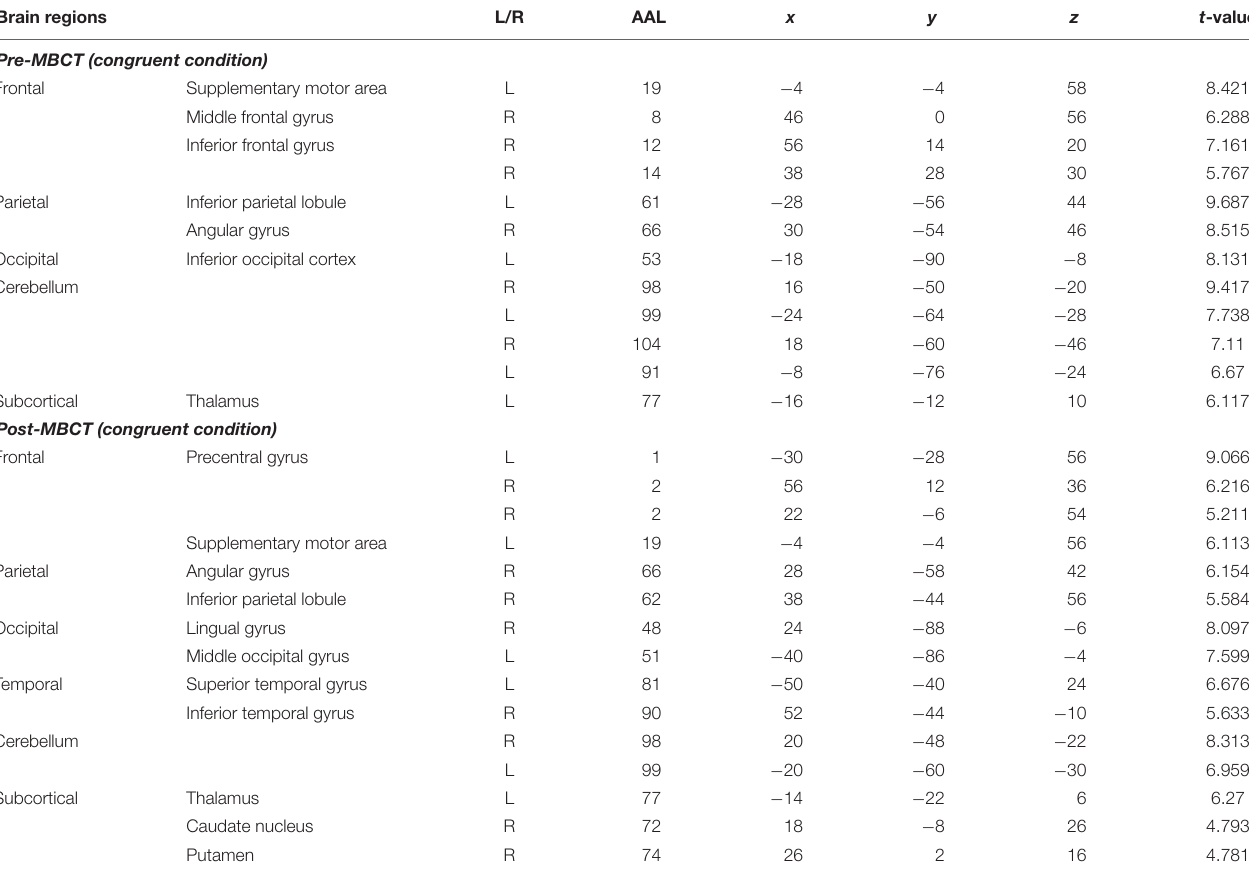
TABLE 3 | Peak locations of brain activities associated with congruent condition during the numerical Stroop task, including before and after the MBCT intervention (AlphaSim corrected p < 0.05). Brain regions